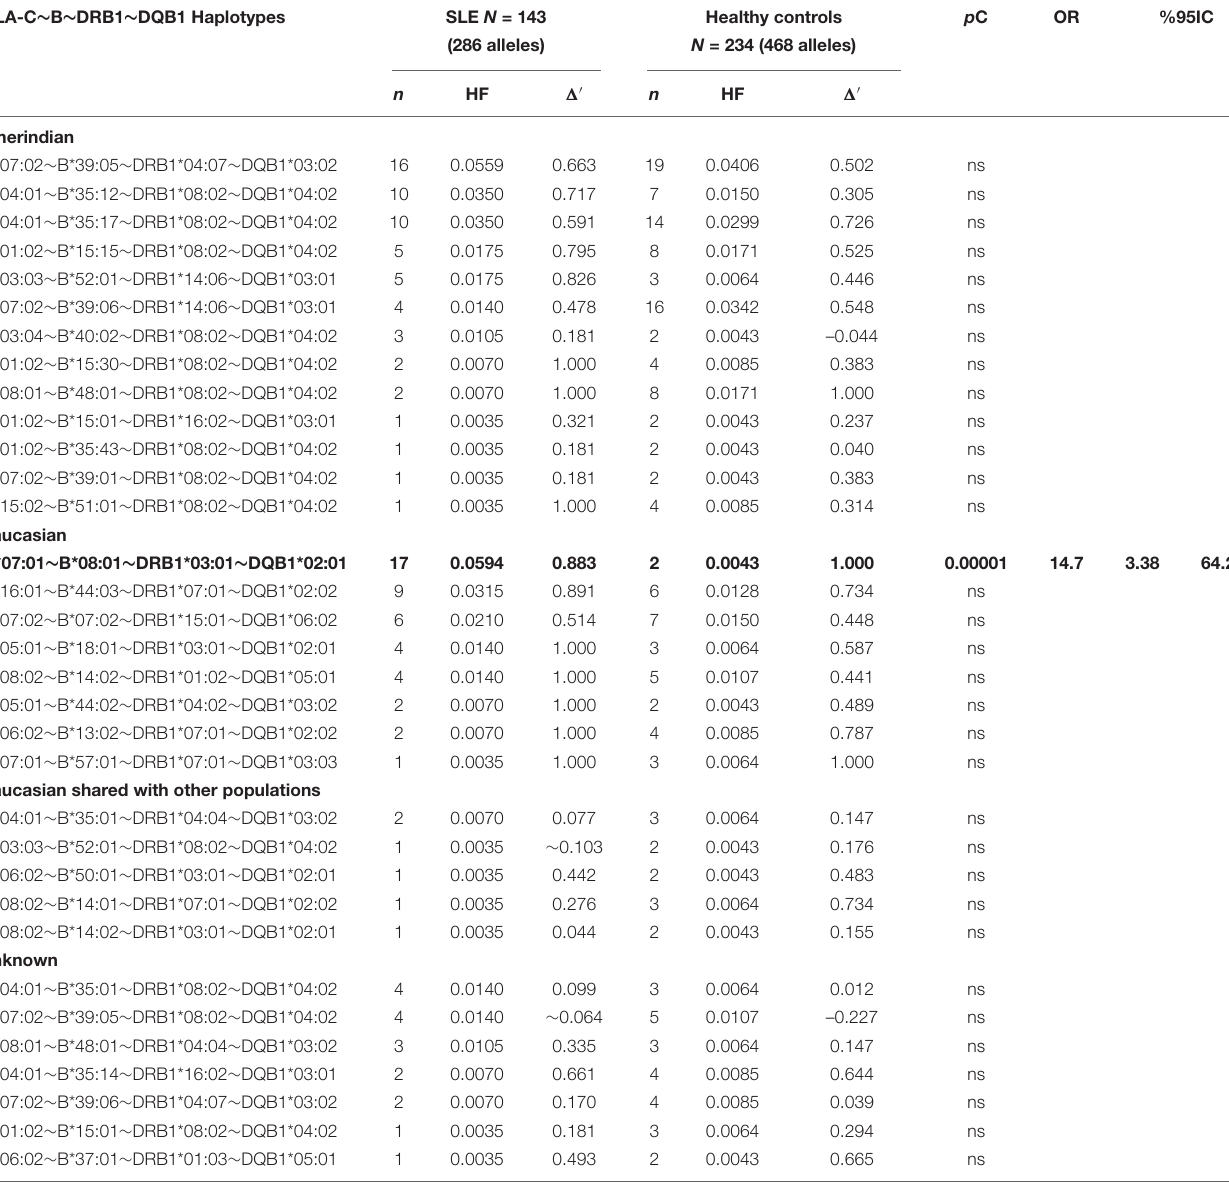
TABLE 6 | Frequencies of HLA-C ∼ B ∼ DRB1 ∼ DQB1 haplotypes in SLE patients and healthy individuals. HLA-C ∼ B ∼ DRB1 ∼ DQB1